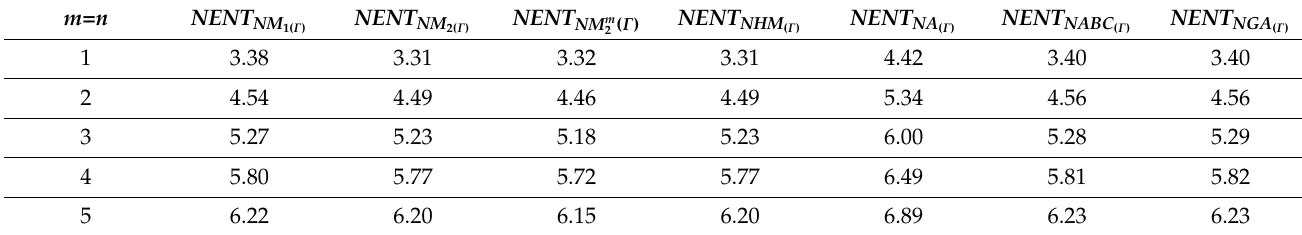
Table 5. Comparison Table for Theorem